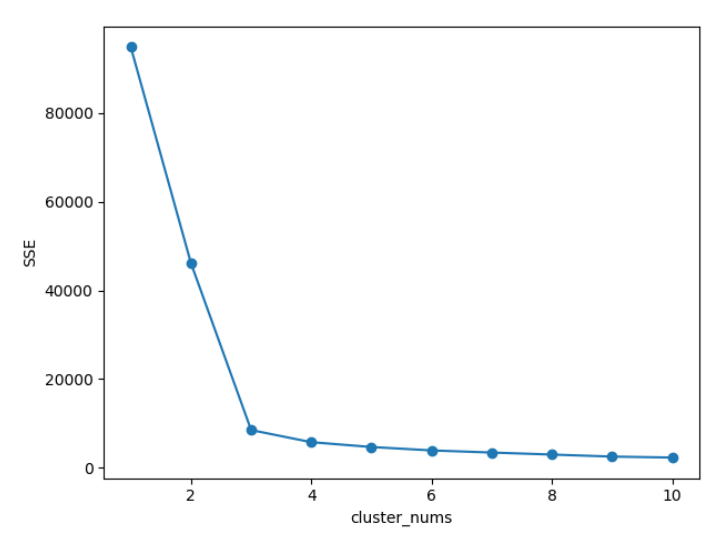
Figure 16. Result of Interest group division.